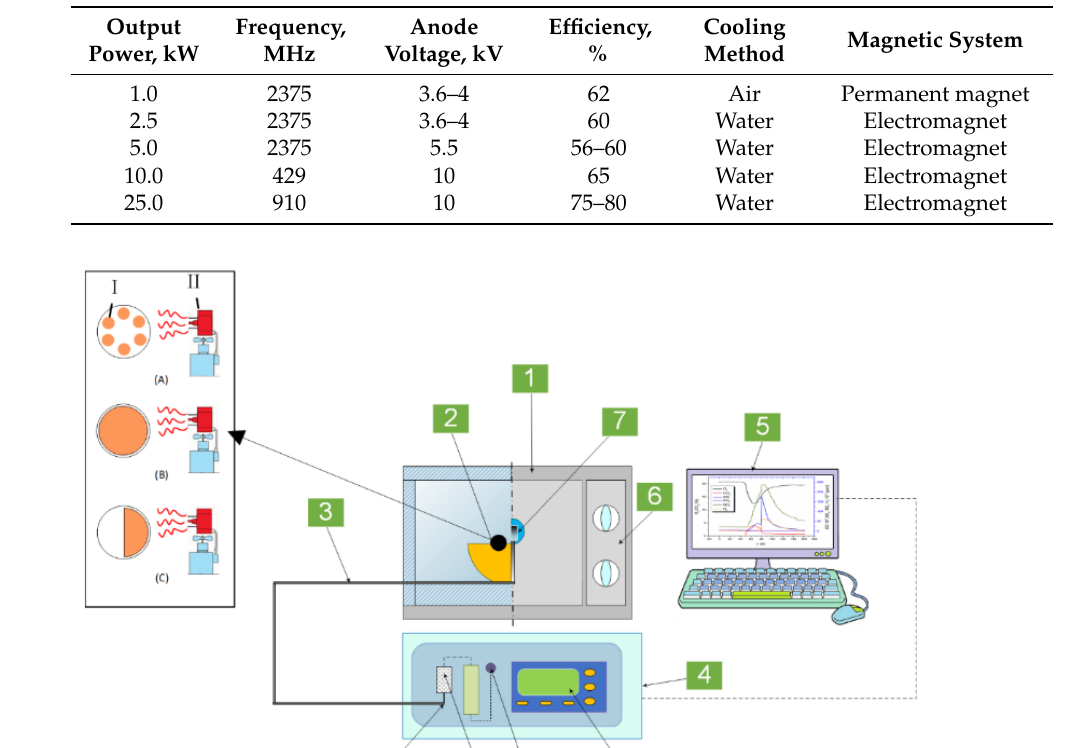
Table 2. Characteristics of magnetrons [54].